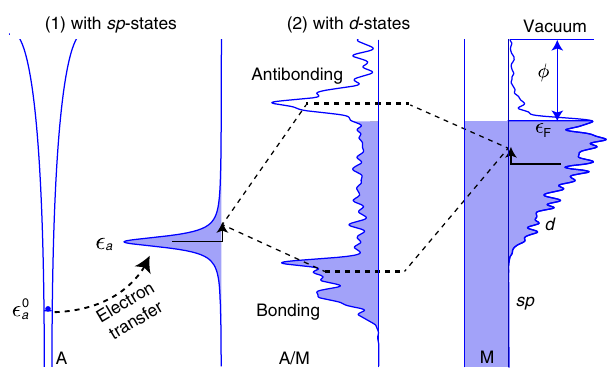
Fig. 1 Illustration of chemical bonding at transition-metal surfaces within the d -band reactivity theory. An adsorbate A with a valence electron at a fi rst interacts with the free-electron-like sp -states discrete energy level ϵ 0 a of the substrate M, forming a broadened resonance at ϵ a accompanied with electron transfer. Conceptually, it further overlaps and hybridizes with the narrowly distributed d -states, which leads to a splitting into bonding and antibonding states. The work function ϕ and Fermi level ϵ F of M are